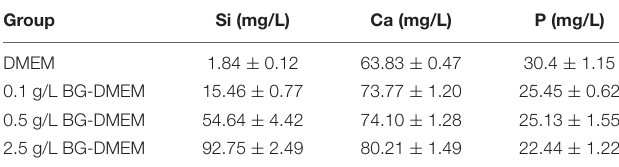
TABLE 1 | Si, Ca, and P ion concentration in BG ionic extraction in DMEM. Group Si (mg/L) Ca (mg/L) P (mg/L) DMEM 1.84 ± 0.12 63.83 ± 0.47 30.4 ± 1.15 0.1 g/L BG-DMEM 15.46 ± 0.77 73.77 ± 1.20 25.45 ± 0.62 0.5 g/L BG-DMEM 54.64 ± 4.42 74.10 ± 1.28 25.13 ± 1.55 2.5 g/L BG-DMEM 92.75 ± 2.49 80.21 ± 1.49 22.44 ±